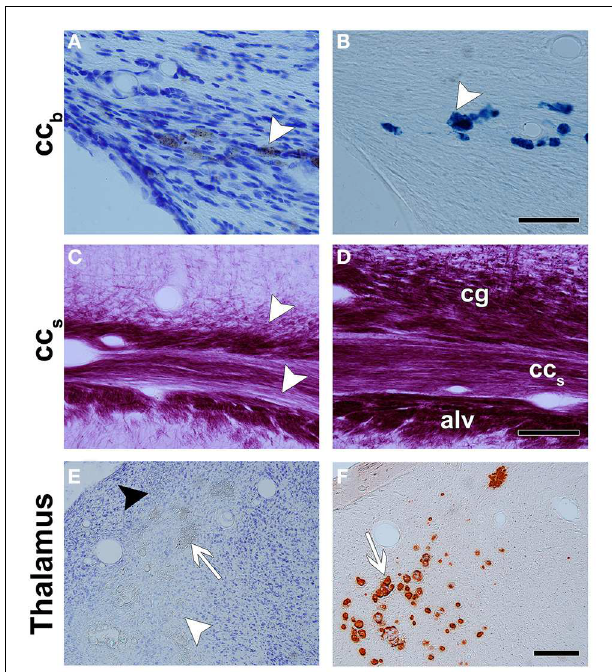
FIGURE 3 | Representative photomicrographs of Nissl- (A,E), Perl’s- (B), myelin- (C,D), and alizarin- (F) stained sections. The corpus callosum shows bleeding with a high iron content between the axons, which are dark in Nissl staining (white arrowhead in A ) and intense blue in Perl’s staining (white arrowhead in B ). (C,D) are photomicrographs of a myelin-stained section of the ipsilateral and contralateral hemispheres in a TBI animal, respectively. There is a loss of myelinated axons in the splenium of the corpus callosum and in adjacent areas, the cingulum and the alveus. In the thalamus, neurodegeneration (white arrowhead), gliosis (black arrowhead), and calcification (white arrow) are observed in Nissl-stained sections (E) . Alizarin-stained sections show calcifications in intense red (white arrow in F ). Abbreviations: alv , alveus; cc b , body of the corpus callosum; cg , cingulum; cc s , splenium of the corpus callosum. Scale bars: 50 µ m (A,B) , 100 µ m (C,D) , and 300 µ m (E,F)